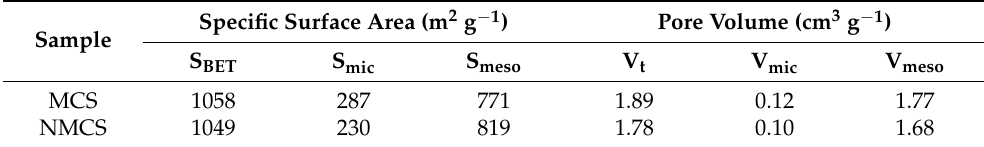
Table 1. Pore structural parameters of MCS and